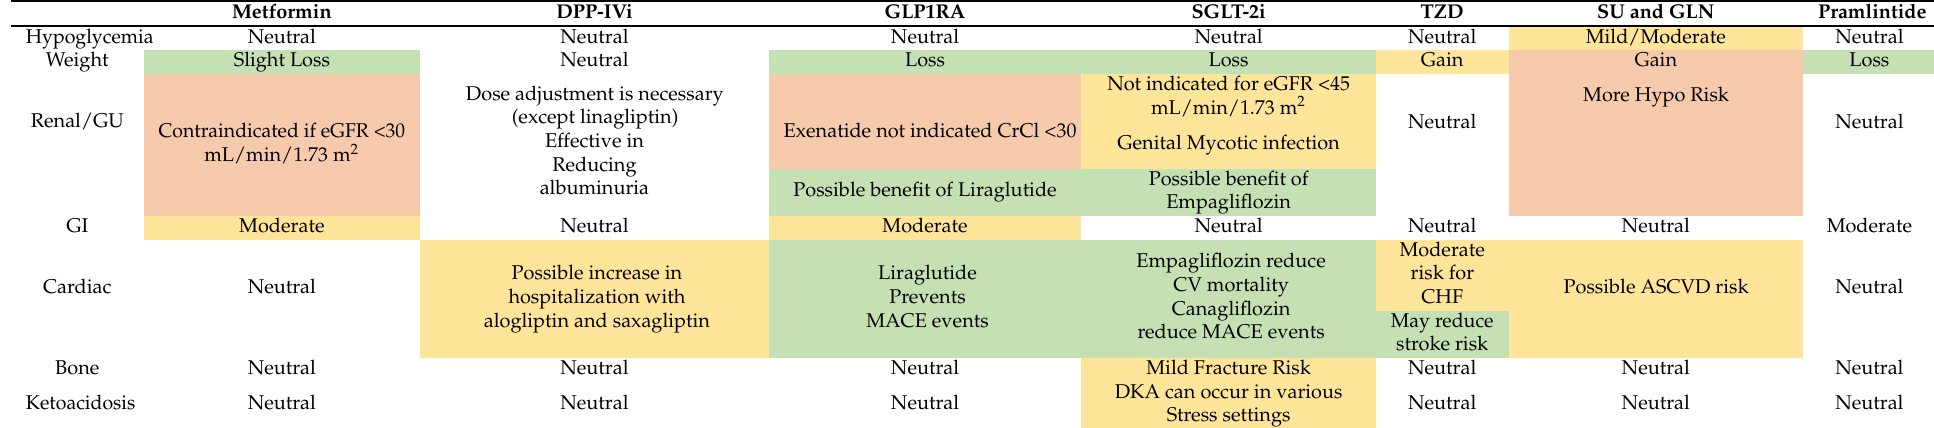
Table 2. Profiles of T2DM therapy.